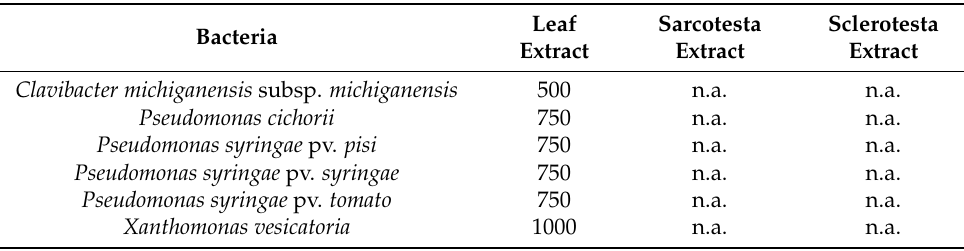
Table 1. Minimum inhibitory concentrations (expressed in µ g · mL − 1 ) of G. biloba extracts against the horticultural